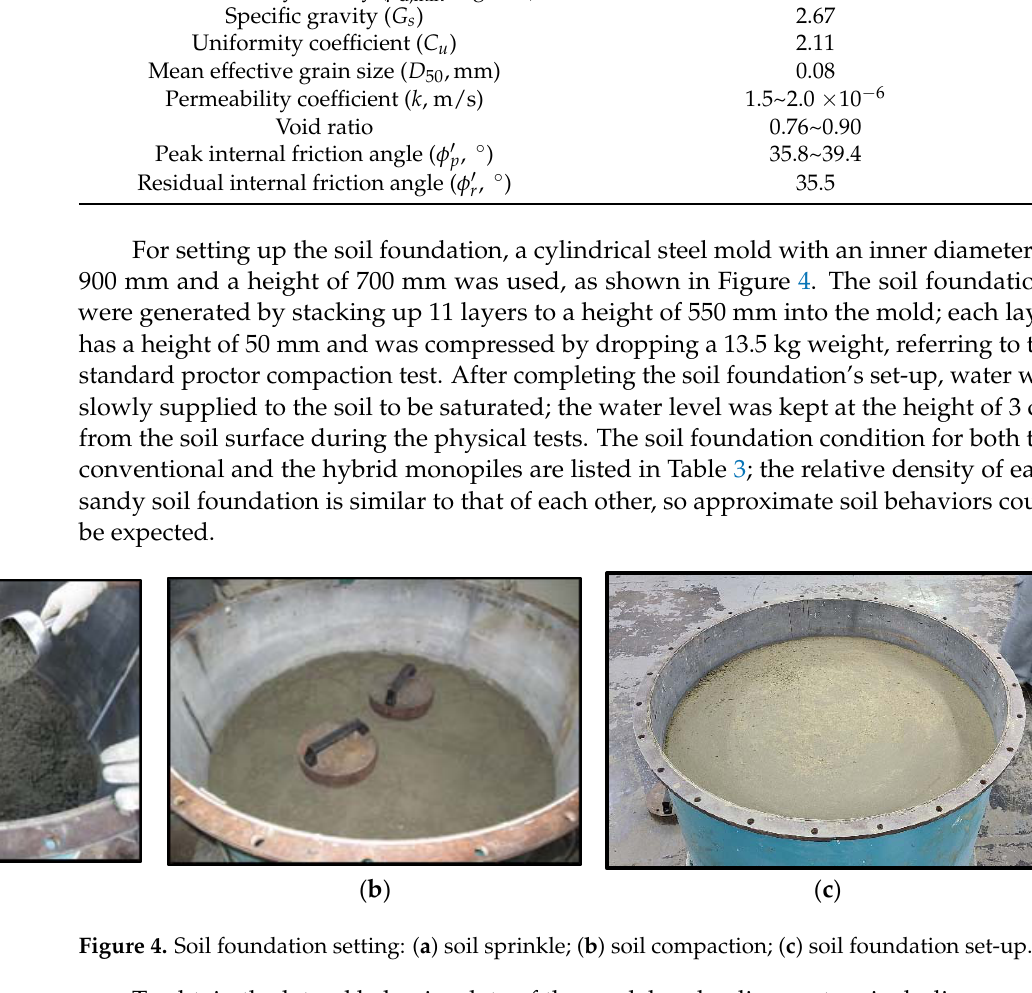
( b ) Figure 5. Loading system: ( a ) main components; ( b ) laser senor measurement.